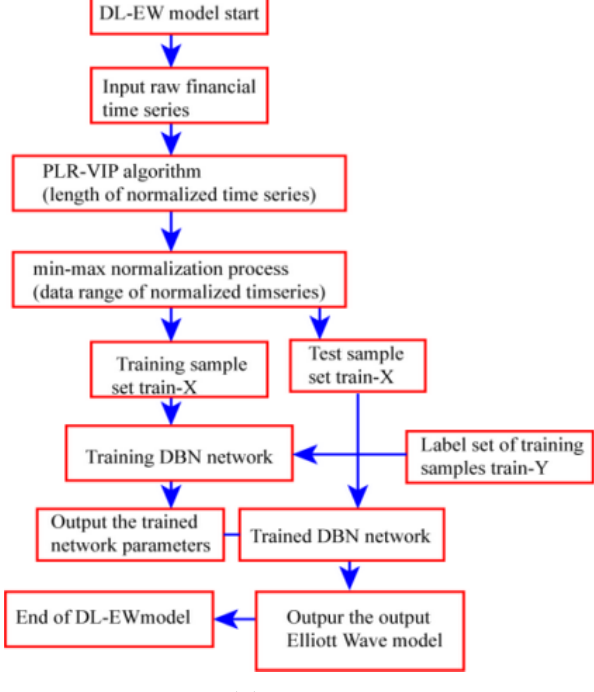
Figure 4. DL-EWP